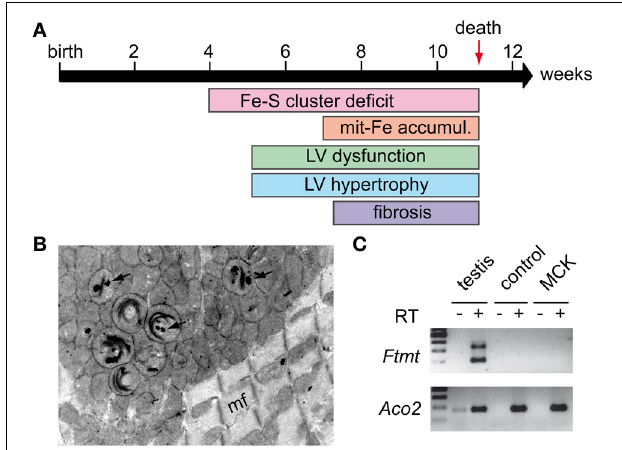
FIGURE 3 | MCK mouse model. (A) Phenotypic characteristics of the MCK mouse model: MCK mice develop progressive hypertrophic cardiomyopathy characterized by progressive left ventricule (LV) dysfunction and hypertrophy starting around 5 weeks of age. The cardiomyopathy leads to cell death and fibrosis. MCK mice prematurely dye around 11 weeks. Fe-S cluster deficit is a primary feature in the mouse pathology with significant differences observed in 4 weeks old mice. Mitochondrial iron (mit-Fe) accumulation is observed in the later stage of the disease. (B) Electron microscopy picture obtained from a heart sample of a 7 weeks old MCK mouse showing mitochondrial abnormalities, in particular collapse cristae and electron-dense deposits (arrows) corresponding to mitochondrial iron deposits. mf, myofiber. (C) Semi-nested PCR on cDNA from heart samples of 8 weeks old control and deleted MCK mice was performed as described (Santambrogio et al., 2007) to assess mitochondrial ferritin (FTMT) expression. Total RNA from tissue was extracted using Trizol ® reagent (Life Technologies) and submitted ( + ) or not ( − ) to reverse transcription (RT). Testis cDNA was used as positive control for Ftmt expression, and a classical PCR to amplify mitochondrial aconitase (Aco2) cDNA was carried out as a control for reverse transcription and loading. Samples without reverse transcription (RT–) were used as control for specific PCR